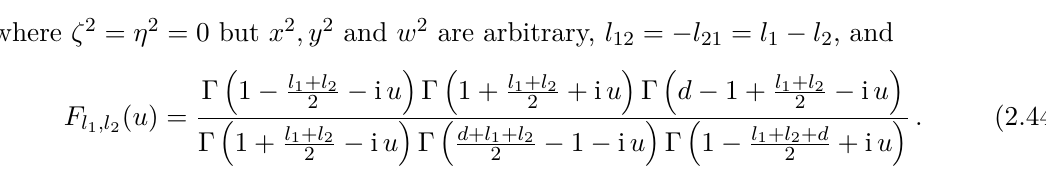
Figure 5 . Integral representation of a matrix element of the fused R-matrix R l into the interchange